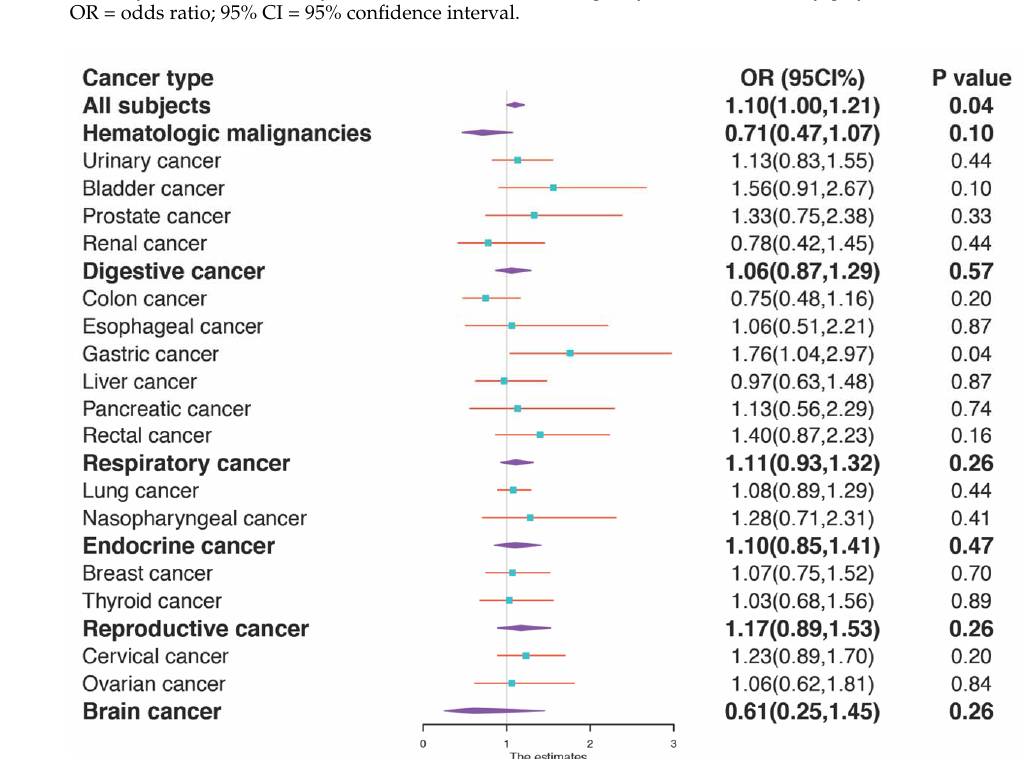
Table 2. Sensitivity analyses on the association of HEV exposure and cancer risk in patients with gastric cancer.